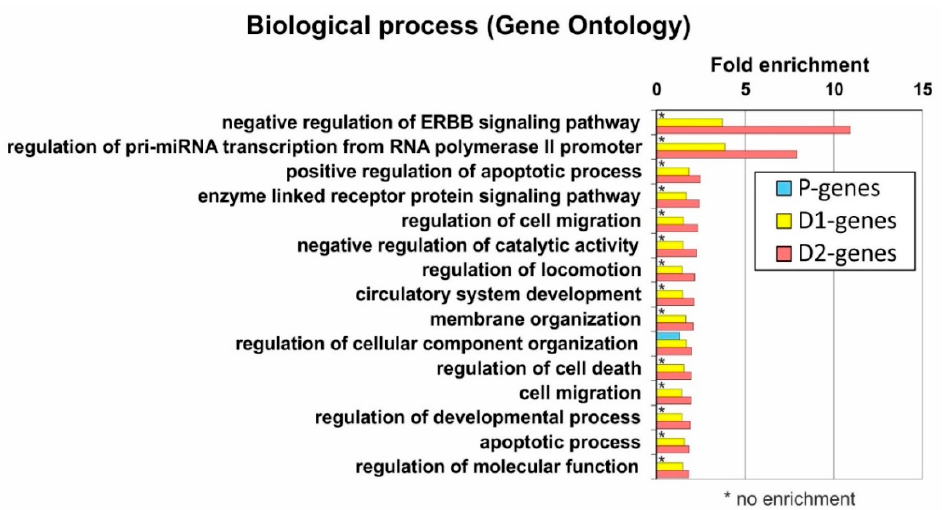
Figure 6. Enrichment analysis of GO-terms (biological process) characteristic for D2 genes for all groups of genes (D1-, D2-, and P genes). Fold enrichment was determined using DAVID [54] .